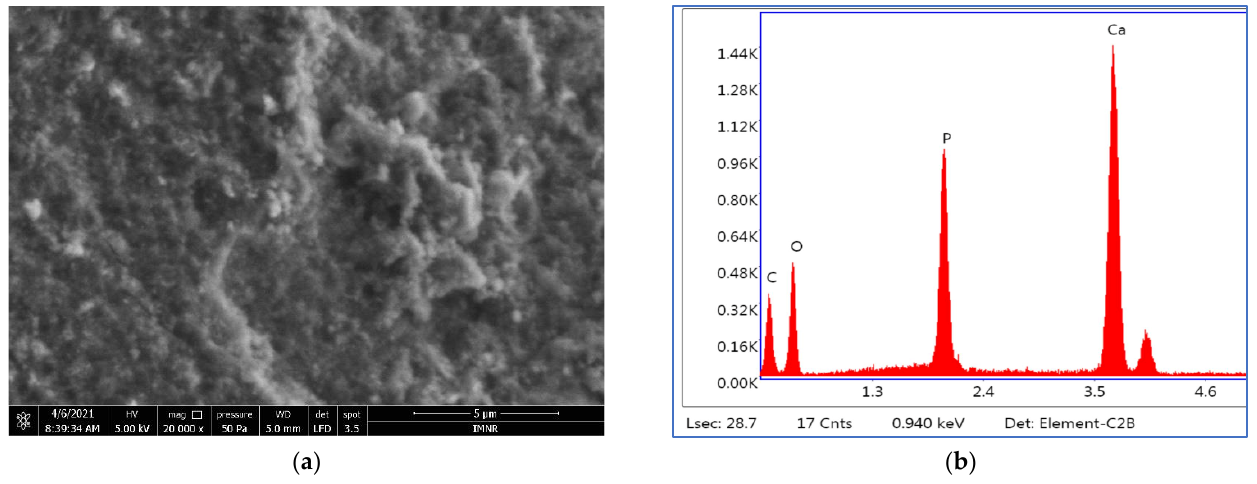
Figure 3. ( a ) SEM image at 5 µ m scale bar, 5 kV voltage, and 20 kX magnification, and ( b ) EDS spectrum of HAP-100 nanopowder.